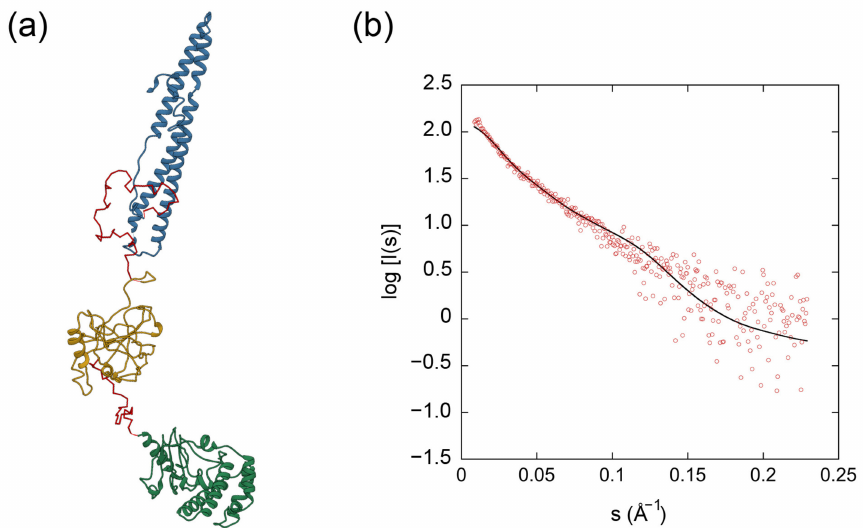
Figure 6. Multi-domain modeling by CORAL of the full-length EspK. ( a ) Multi-domain model of the N-terminal domain (blue), the middle region (yellow) and the C-terminal domain (green) connected by linkers (red). ( b ) Fit of the calculated SAXS scattering curves from the multi-domain model (black line) compared to the experimental scattering signal